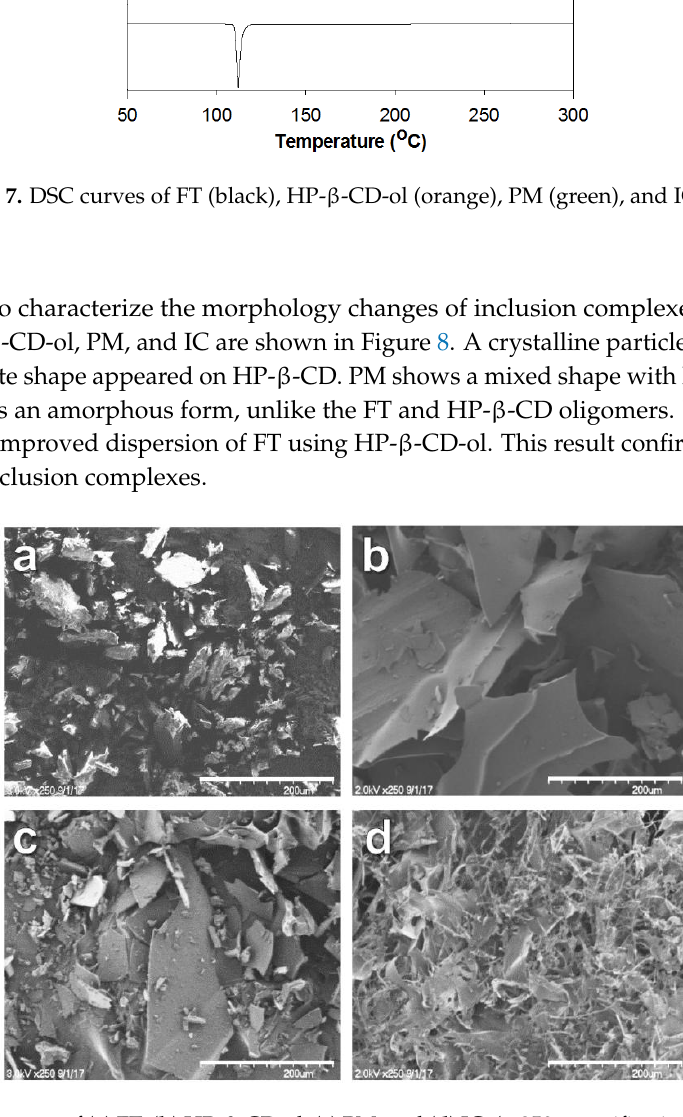
Figure 8. SEM images of ( a ) FT; ( b ) HP-β-CD-ol; ( c ) PM; and ( d ) IC. (×250 magnification, bar = 200 μm).